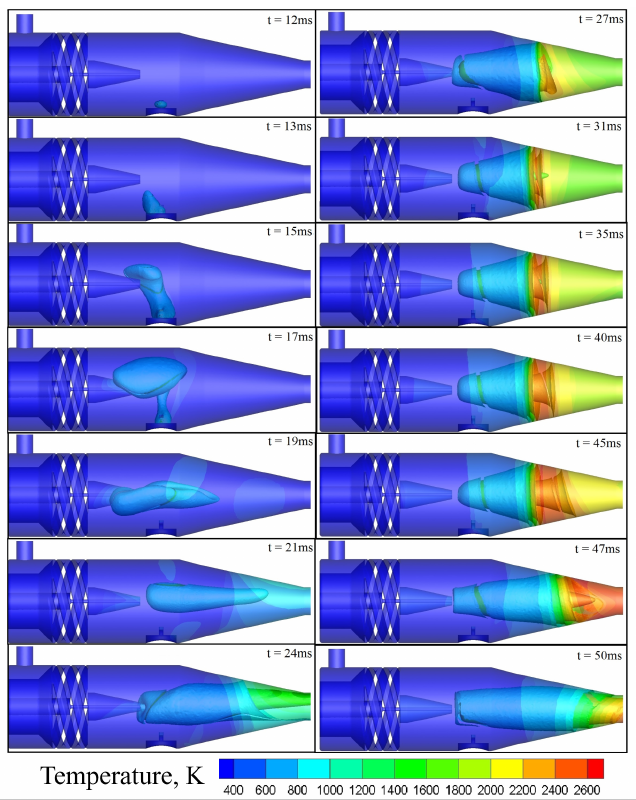
Figure 9. Temperature distribution during successful ignition process, case 1.